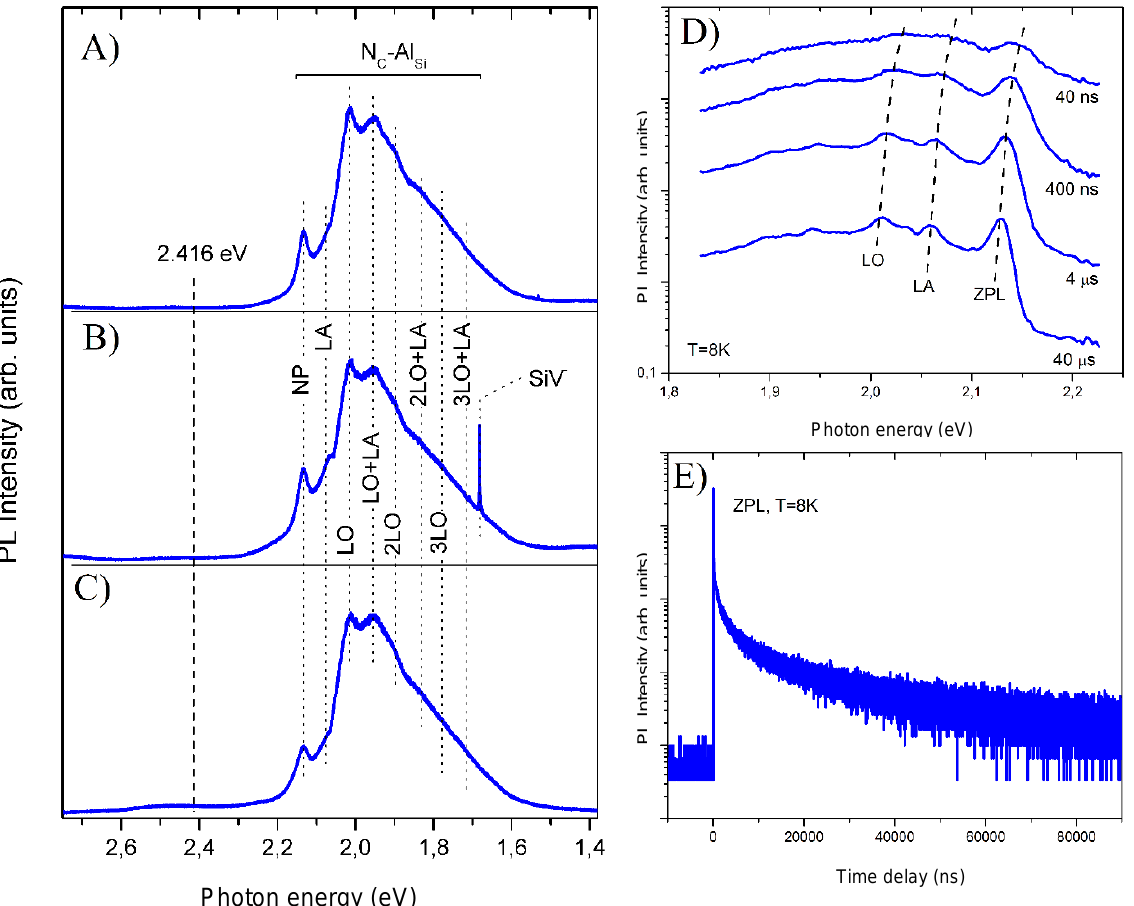
Figure 4. Examples of low-temperature (5K) photoluminescence spectra recorded for the as-grown (panels A , B ) and annealed crystals (panel C ). Panel ( A ) corresponds to the synthesis conditions in which the formation of side phases was not detected. Panel ( B ) corresponds to the situation in which metastable silicon and diamond were formed along with SiC during the synthesis. The dotted line marks the position of the fundamental absorption edge of 3C SiC. (Panels D , E ) show time-resolved PL spectra and PL kinetics corresponding to the steady-state spectrum in Panel ( A ).